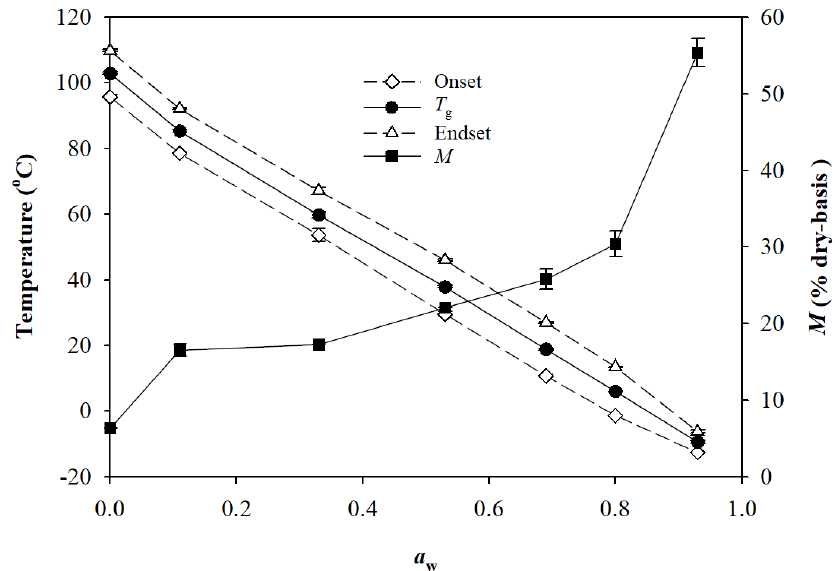
Figure 6. Onset, mid, and endset temperatures of endothermic steps in DSC thermograms of resistant maltodextrin (RM), equilibrated at 25 ◦ C under different relative humidities (RH). The RH was expressed as water activity ( a w = RH/100), and the midpoint was used as glass transition temperature ( T g ).